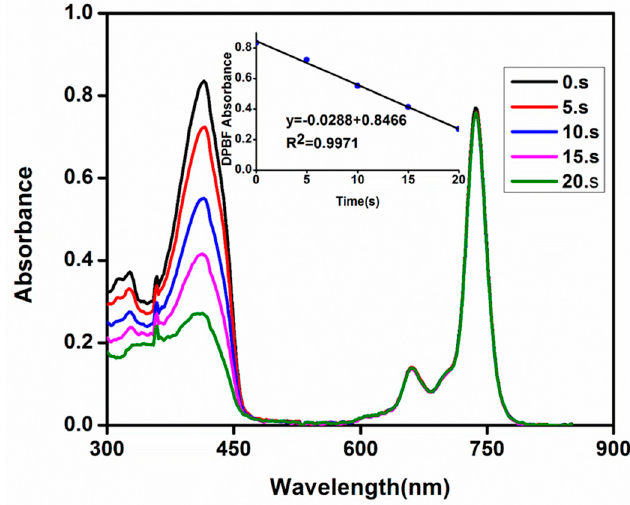
Figure 2. UV-Vis absorption spectral changes for the phthalocyanine 3b in the presence of DPBF during the determination of singlet oxygen quantum yield at a concentration of 1 × 10 − 5 M in DMSO. Insets: 1,3-Diphenylisobenzofuran (DPBF) absorbances versus time.